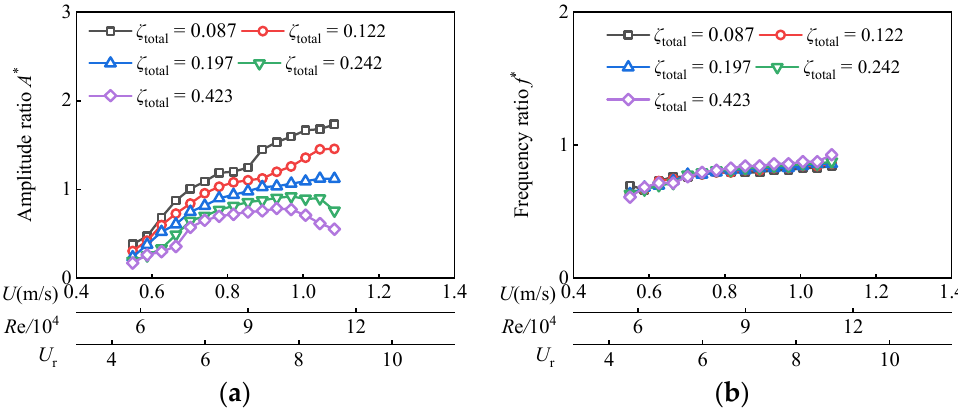
Figure 8. FIM of Cir-T-Att with D = 0.12 m, Re = 5.79 × 10 4 ~1.38 × 10 5 . ( a ) Amplitude ratio. ( b ) Frequency ratio.